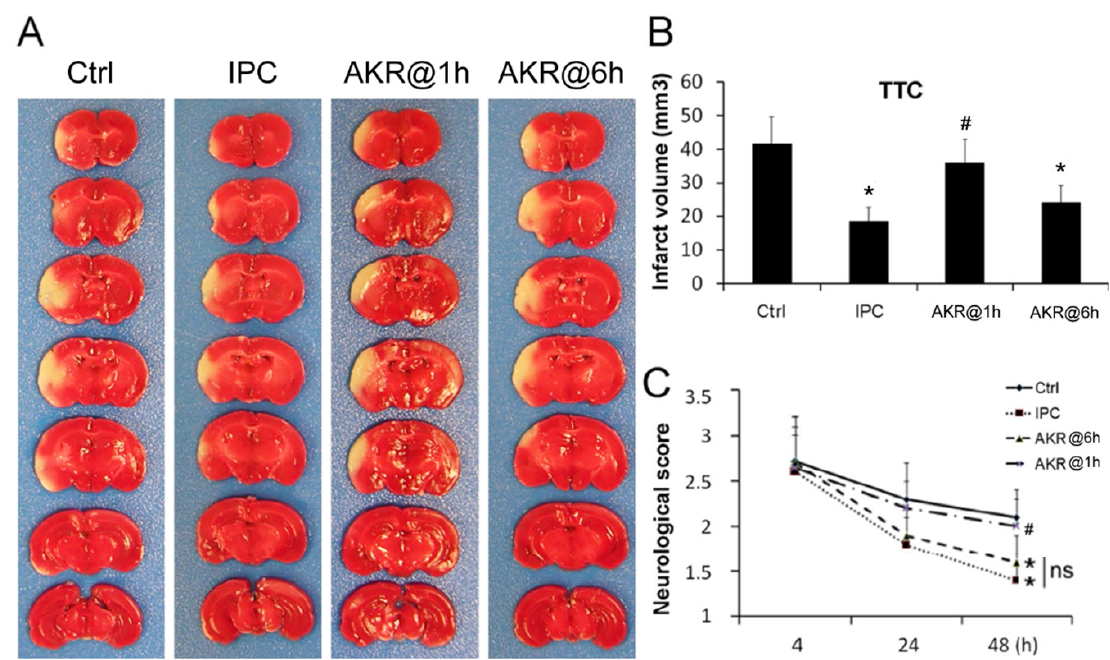
Figure 3. Early injection of AKR1C15 abolished the protective role of IPC. At 1 h or 6 h after IPC, mice were i.p. injected with TAT-AKR1C15 at 5 mg/kg, and MCAO was performed 3 days after IPC. ( A ) Representative photographs of TTC-stained brain sections and ( B ) calculated infarct volumes at 48 h post-MCAO. Data are mean ± SD; n = 7–9 animals per group. One-way ANOVA followed by post hoc Tukey’s multiple comparison. ( C ) Neurological scores at 48 h after MCAO. Two-way ANOVA followed by post hoc Tukey’s multiple comparison. Data are mean ± SD; n = 7–9 animals per group. * p < 0.05 vs. Ctrl. # p < 0.05 vs. IPC. ns: not significant.